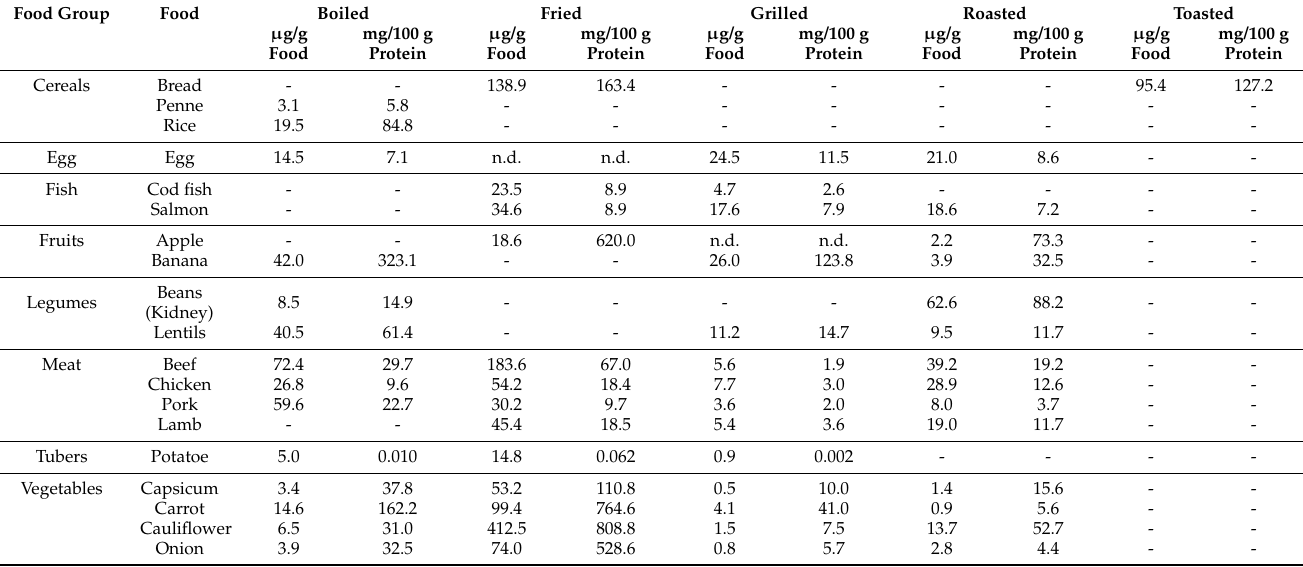
Table 1. Furosine values depending on the cooking method applied to the